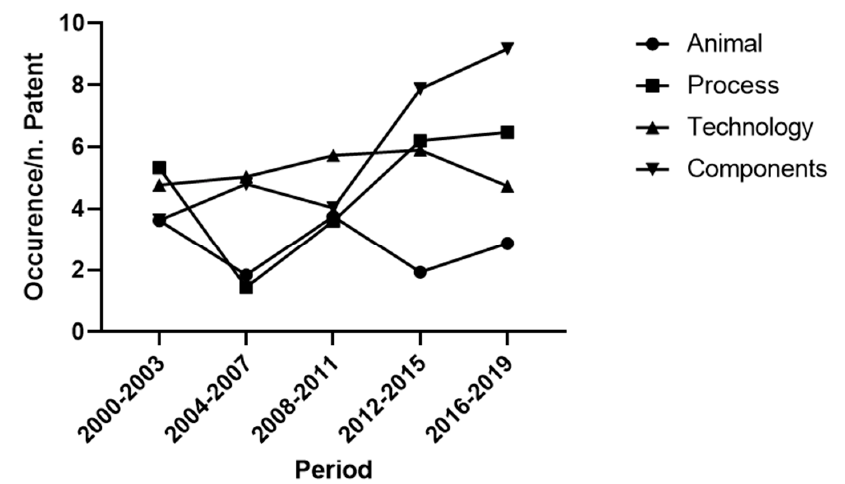
Figure 9. Patents: course of the clusters over the last two decades. The weight of the cluster for each four-year period was calculated as the ratio between the occurrence of words belonging to a cluster and the total amount of